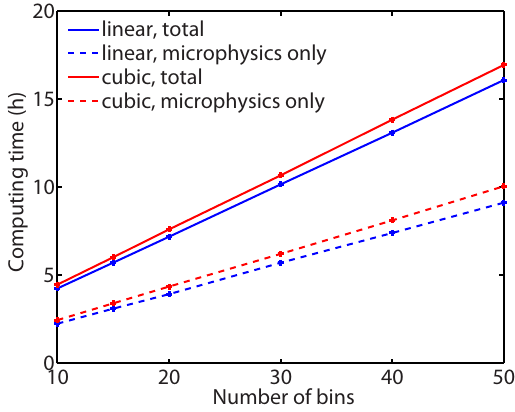
Fig. 8. L 1 difference between the radiative heating rate of the solu- tions obtained by the linear and cubic schemes and that obtained by the cubic scheme at 50-bin-resolution.